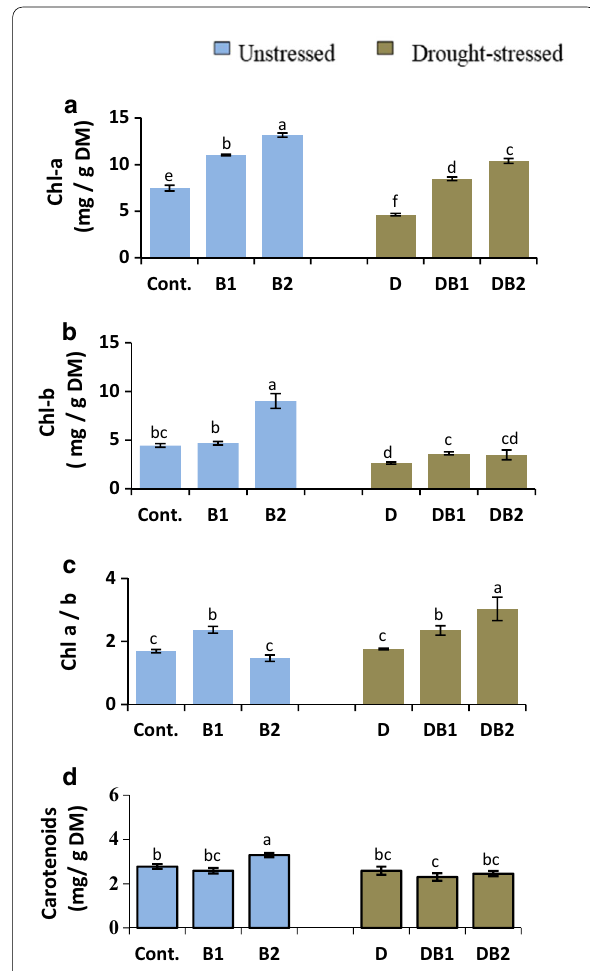
Fig. 3 Effect of bacterial inoculation with Azospirillum brasilense NO40 (B 1 ) and Stenotrophomonas maltophilia B11 (B 2 ) on the contents of a Chl-a; b Chl-b; c Chl a/ b and d carotenoids of the 15-day-old Triticum aestivum L. seedlings (cv. G9) grown in sandy soil, under unstressed and drought-stressed conditions (7 days of water withholding). Error bars represent the standard deviation between 3 replica. Treatments with identical letters are not significant at P 0.01. Cont. unstressed-uninoculated ≤ ≡ treatment; D drought-stressed-uninoculated treatment; B 1 and ≡ B 2 unstressed-inoculated treatments; DB 1 and DB 2 the ≡ = drought-stressed- inoculated